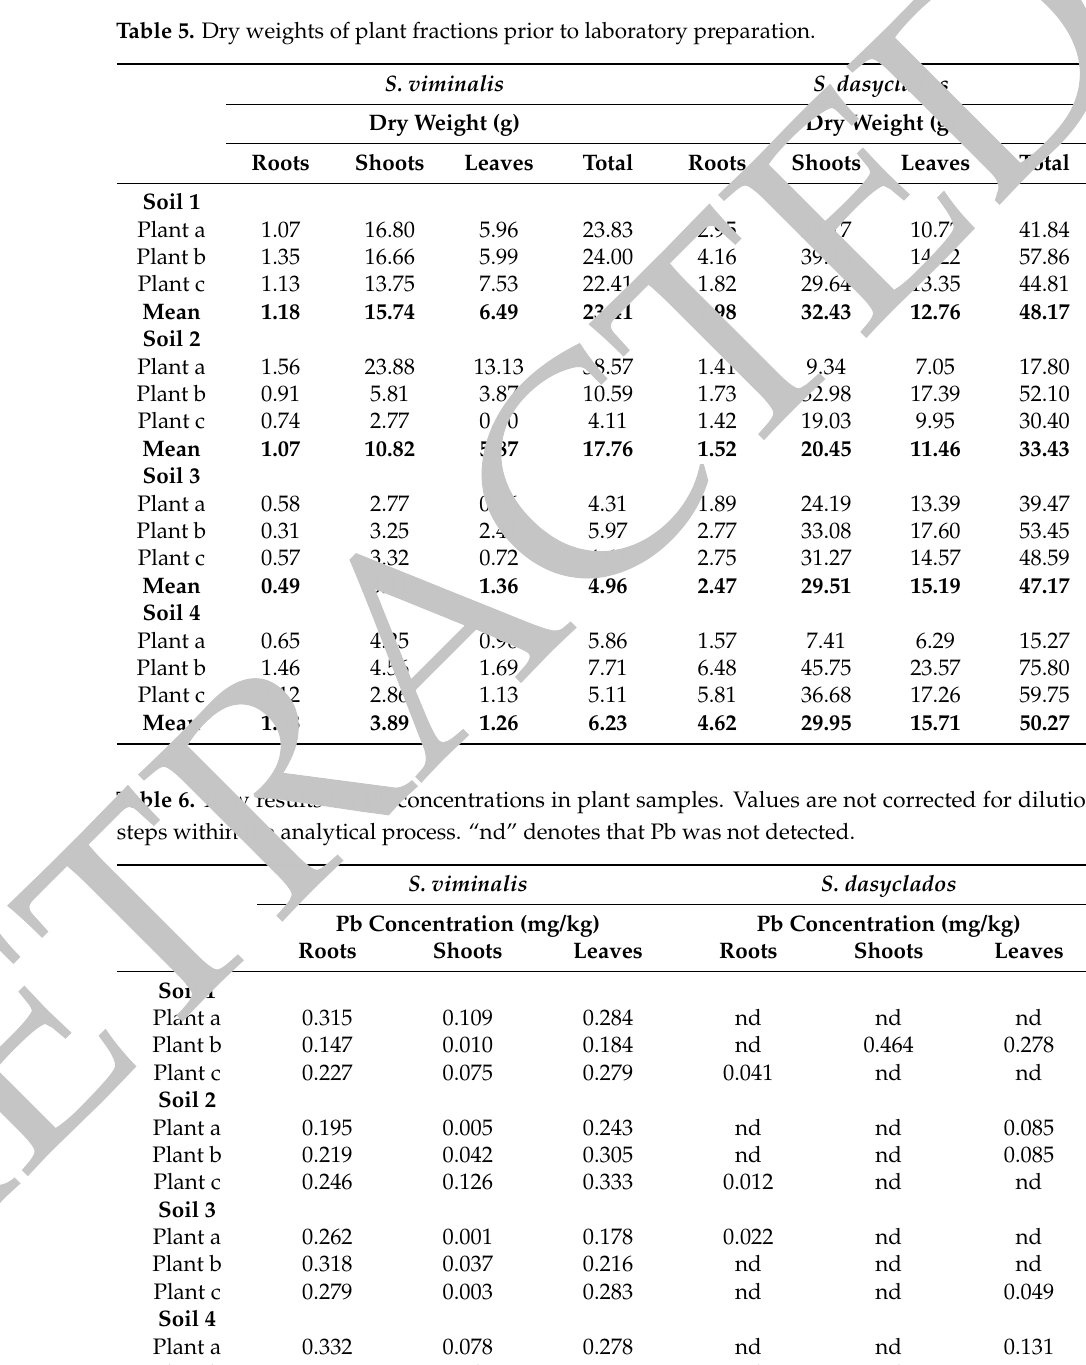
Table 5. Dry weights of plant fractions prior to laboratory preparation.